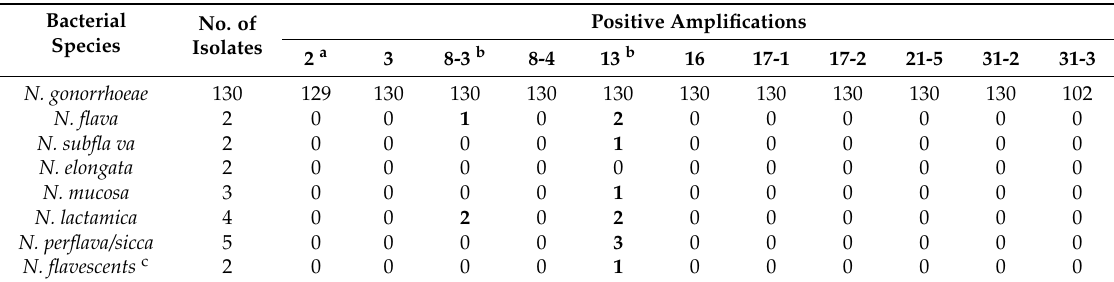
Evaluation of eleven primer pairs using N. gonorrhoeae , non- N. gonorrhoeae and non- Nesseria